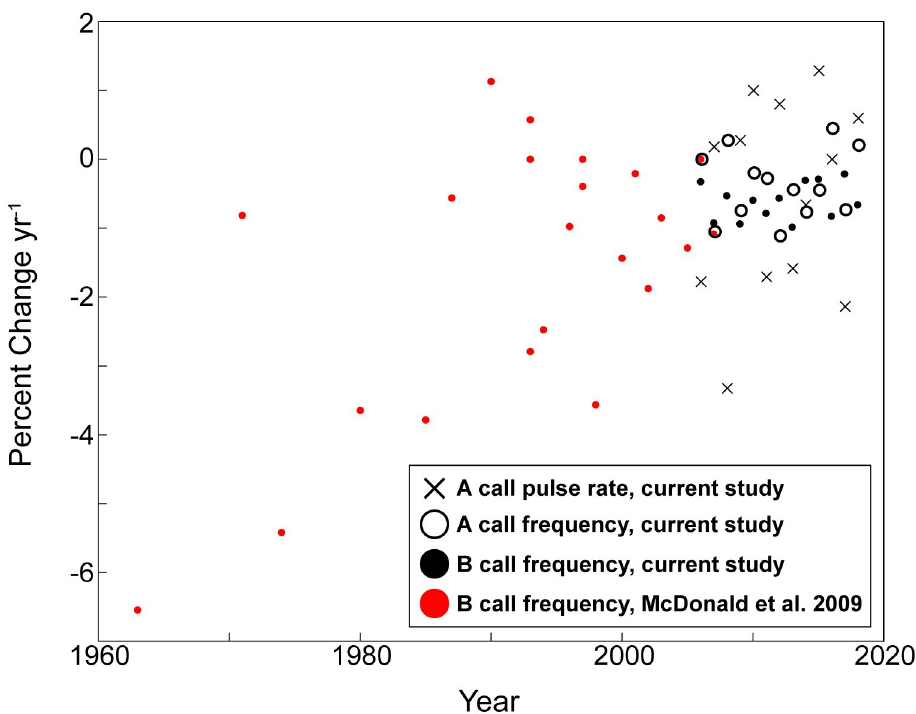
Fig 5. Percent of change of the mean frequency and pulse rate of Northeast Pacific blue whale calls. The percent of change is shown for A calls each year from 2006 to 2019 and for B calls from 1963 to 2019. Data in black are from the current study and data in red are from McDonald et al .